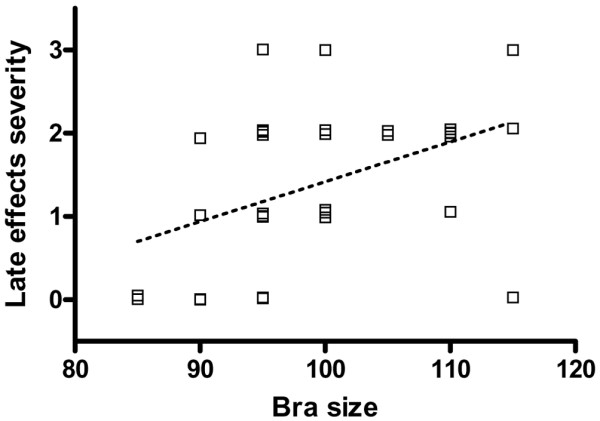
Relation between estimated irradiation volumes and severity of late effects of radiotherapy for breast cancer. Irradiation volumes were estimated from the women's bra size, and the late effects were scored in the same women (n = 33). Dotted line shows the corresponding regression line (P = 0.018).